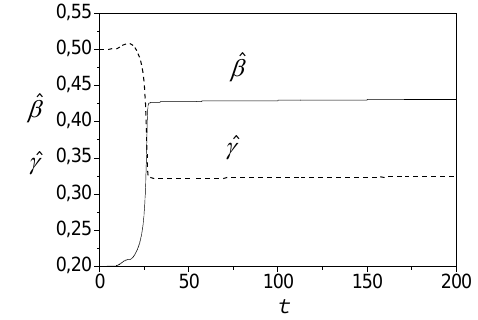
Fig. 4. Tuning of model (10) parameters.